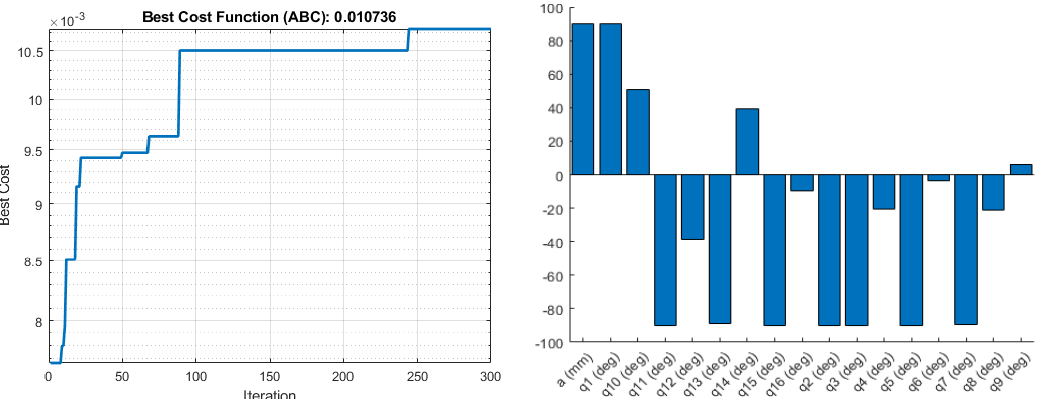
Figure 6. Objective function values ( left ), and the corresponding optimised joint parameters ( right ) for the best objective function value obtained by ABC for the LCI manipulability measure.